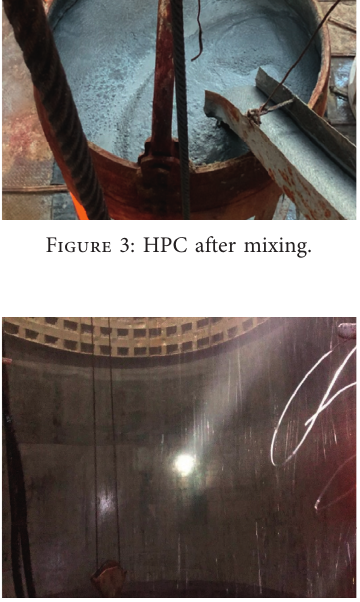
Figure 4: HPC shaft lining after form stripping.